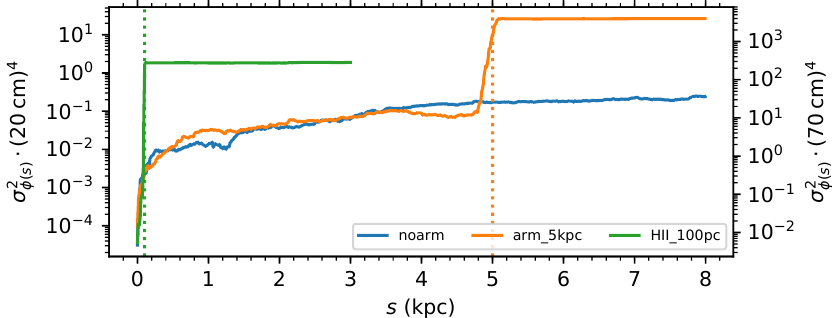
Figure 3. The factor in Equation (6), σ 2 λ 4 , for each of the models. The left axis values are labeled for φ λ = 20cm; the right axis values are labeled for λ = 70cm. When σ 2 λ 4 (cid:29) 10 0 , total depolarization is φ expected in the Burn [1] model. Dotted vertical lines show the position of the arm in each model.